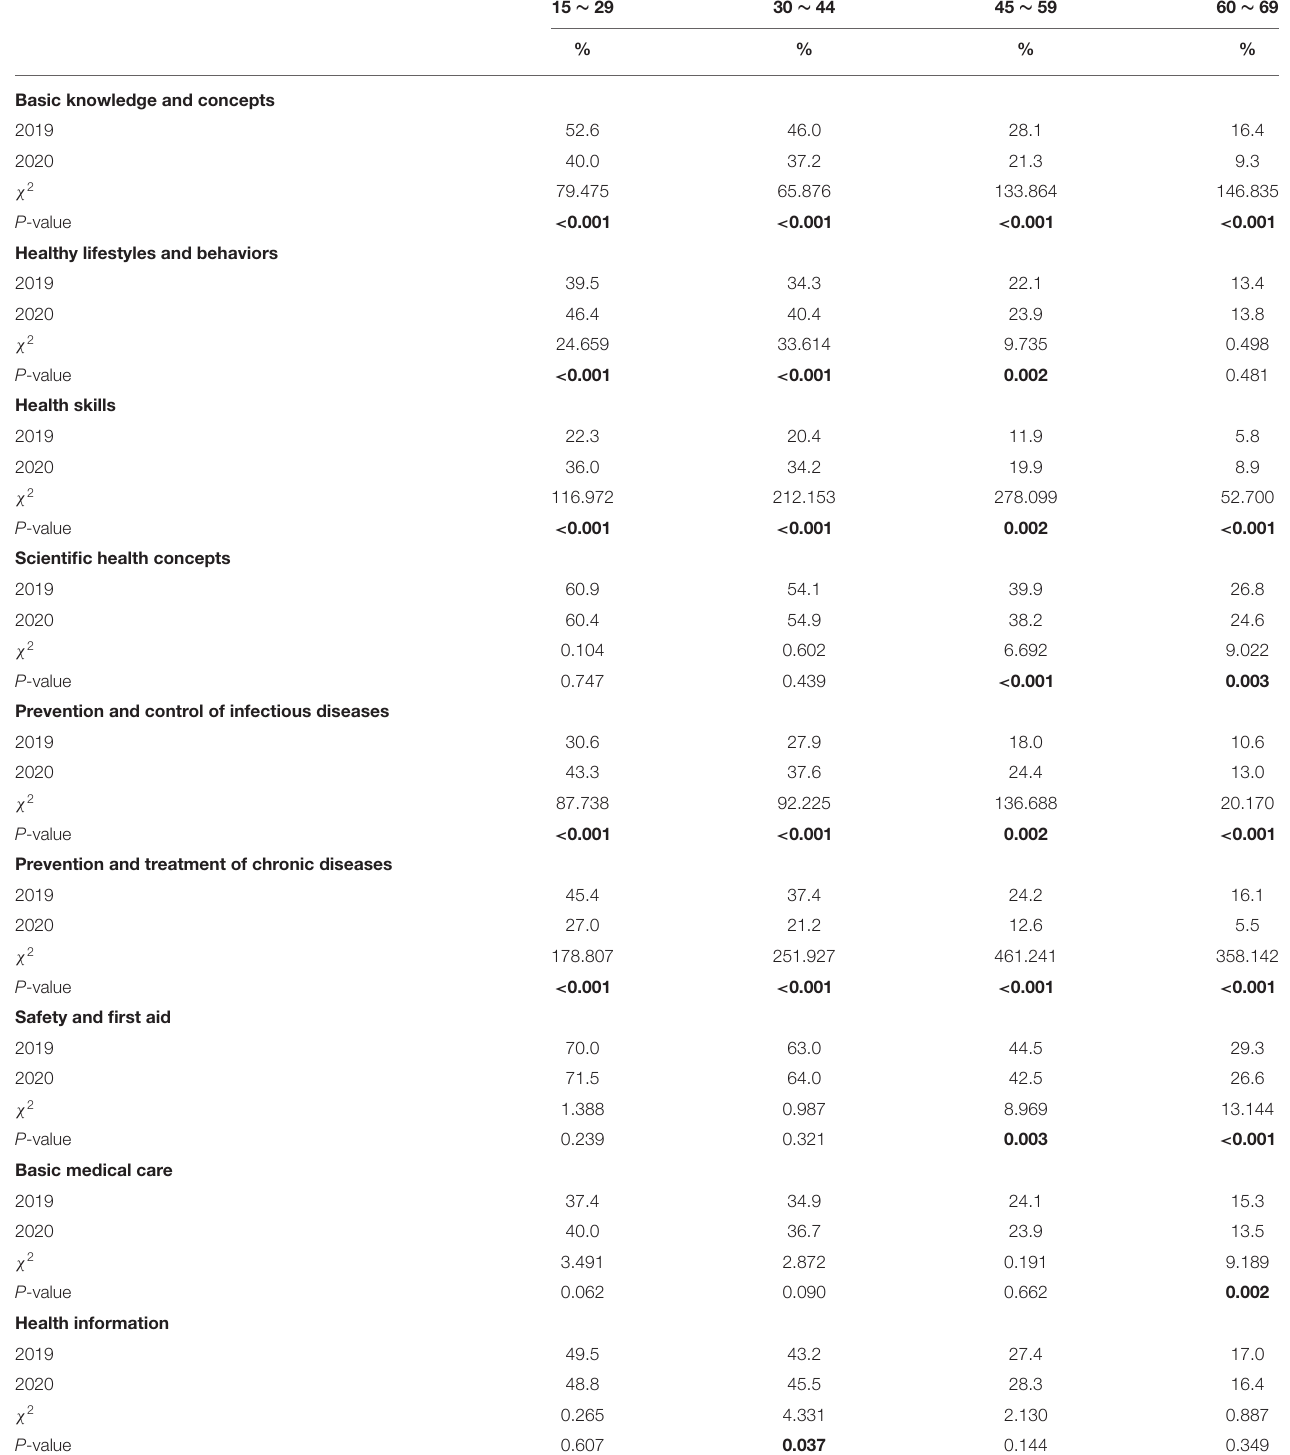
TABLE 3 | Factors associated with health literacy in 3 different aspects and 6 types of health problems (2019 and 2020)* stratified by age groups—results of bivariate